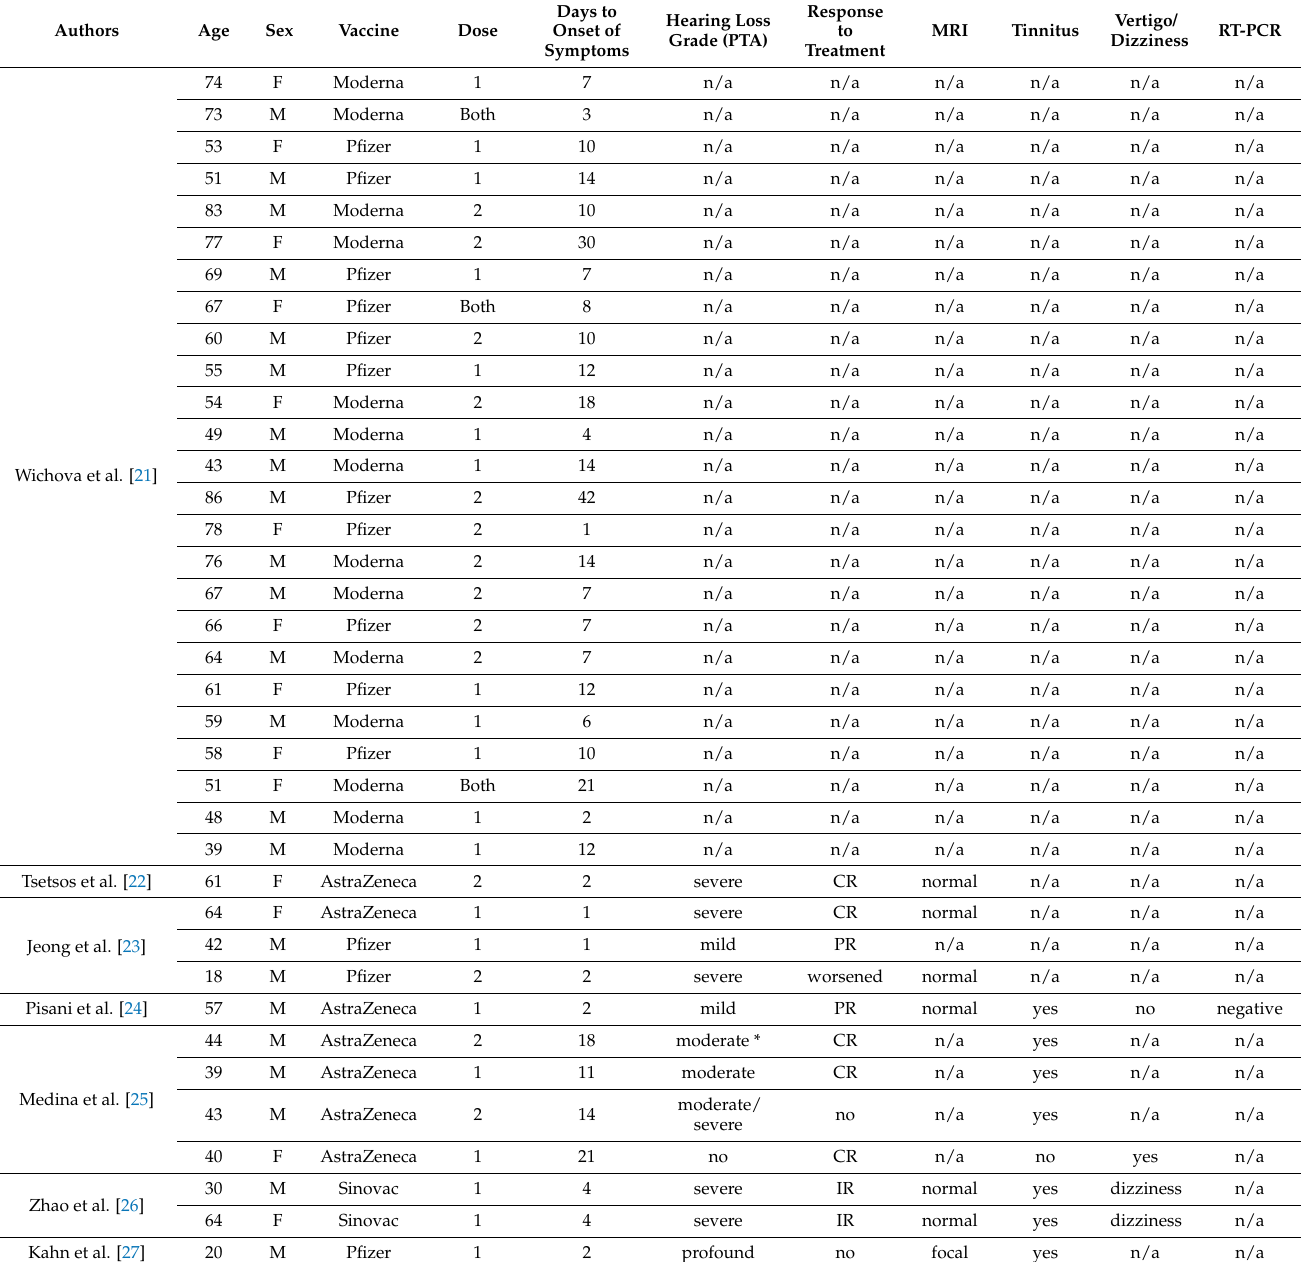
Table 1. SSNHL as COVID-19 adverse events following immunization